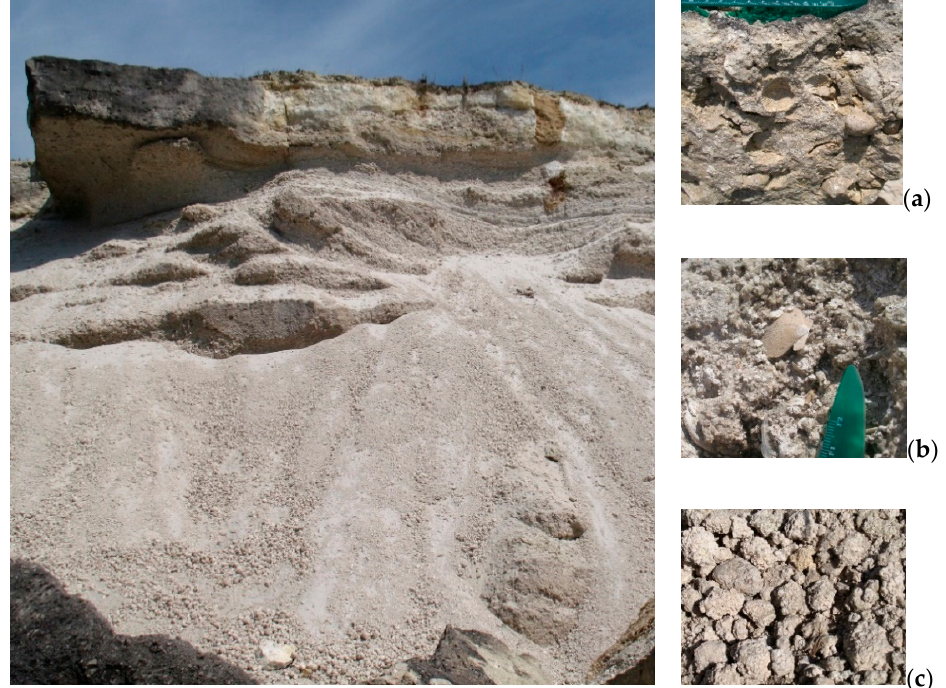
Figure 4. Miocene Lithothamnium limestones in Huta Ró ż aniecka quarry: ( a ) bivalve casts and shells (a coquina bed) [36], ( b ) serpulid–microbial limestones with Chlamys scallop shells [44], ( c ) rhodoliths of up to 4 cm diameter [36].